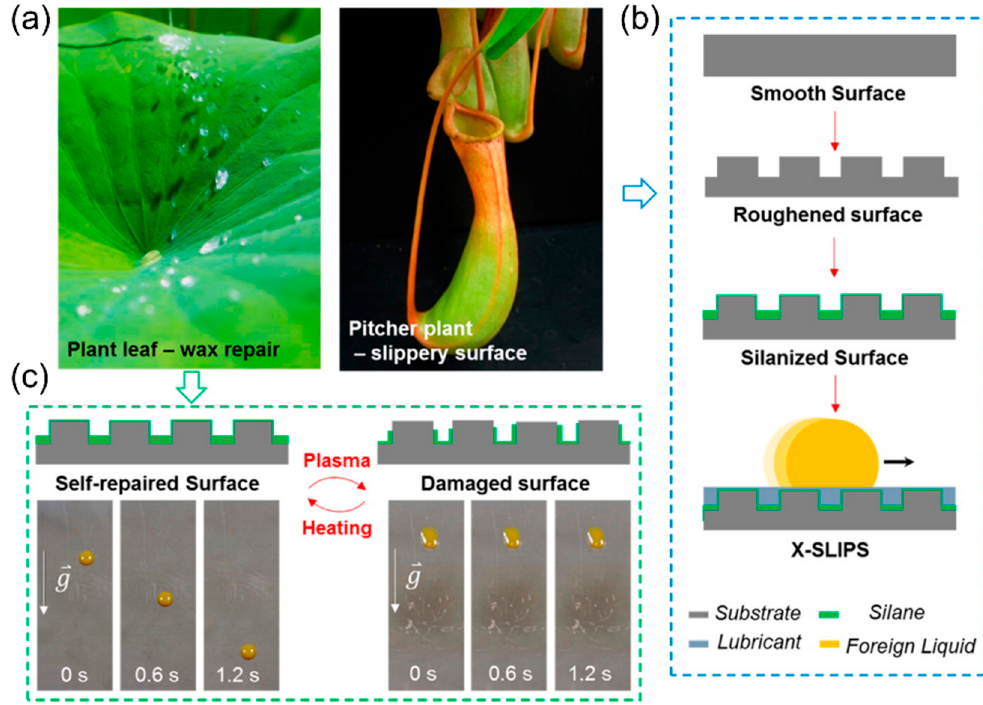
Figure 12. Bioinspired slippery liquid-infused porous surfaces (X-SLIPS) coating with thermal healing function. ( a ) Optical images showing a leaf of Nelumbo nucifera repelling water droplets (left) and a leaf of Nepenthes whose lamina is modified into a pitcher (right). ( b ) Schematic drawing that shows the Nepenthes -inspired fabrication process of a slippery coating. ( c ) Schematics showing the concept of self-repairing surfaces inspired by the wax repair of plant leaves compared with damaged surfaces (above). Liquid repellence of octane droplets on lubricated substrates is shown for undamaged and damaged silane coatings (bottom). Reprinted with permission from [63]. Copyright 2016 American Chemical Society.